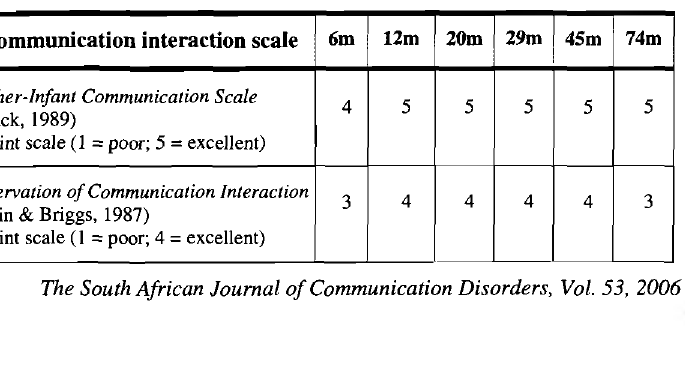
Table 7: Quality of mother-child communication